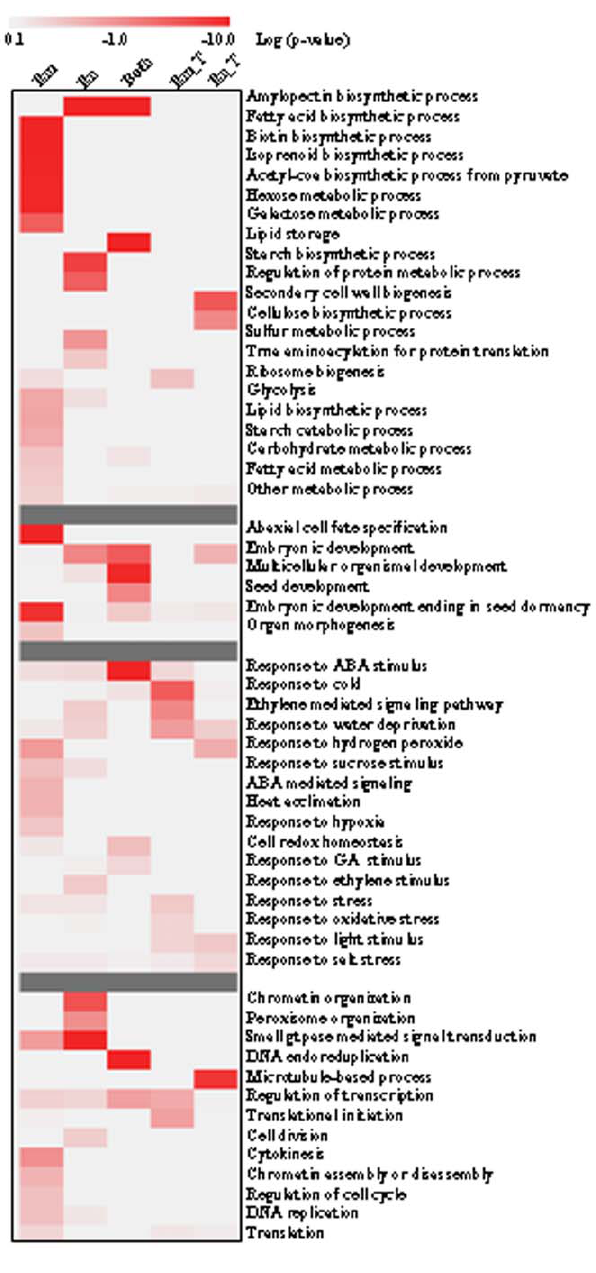
Figure 3. GO category enrichment of seed development- associated genes. The enrichment of process categories associated with metabolism, development, hormone signaling and cellular regulation were shown. ‘‘Em’’ or ‘‘En’’ indicates genes that are predominantly expressed in embryo or endosperm, respectively; ‘‘Both’’ indicates genes that are predominantly expressed in both embryo and endosperm; ‘‘Em_T’’ or ‘‘En_T’’ indicates genes that are regulated in time during embryo or endosperm development, respectively. Chi- square test was performed to calculate the p-values, which were log10 transformed. As indicated in the scale bar, the highly enriched GO categories were in red color.